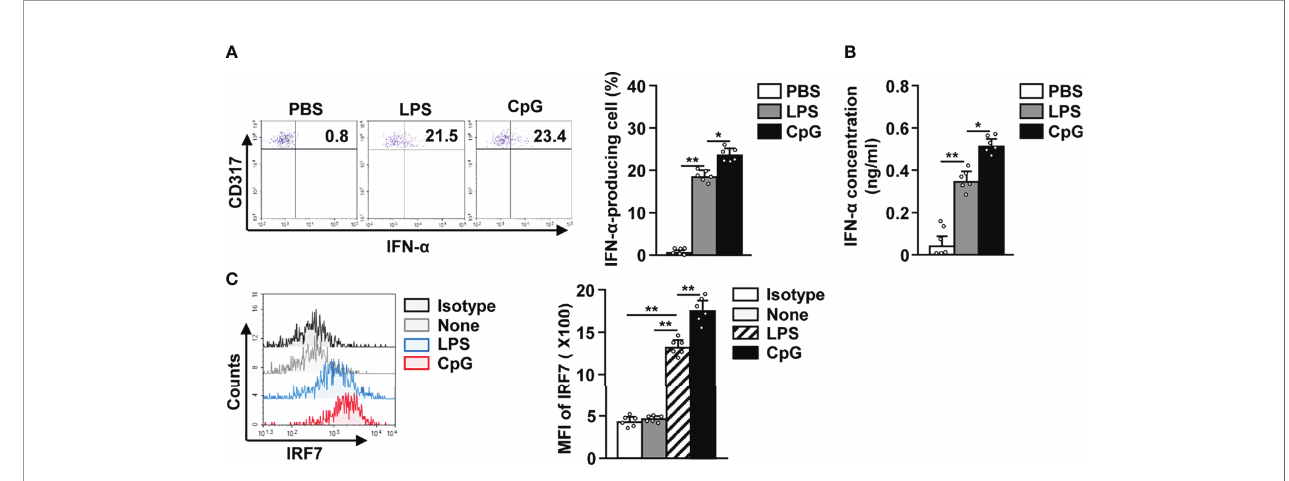
FIGURE 3 | LPS elicited interferon-alpha (IFN- a ) production in pDCs. The LPS (0.1 mg/kg) and CpG (10 mg/kg) were i.p. injected in C57BL/6 mice. Twelve hours after treatment, spleens were harvested and the splenocytes cultured in 2 m M monensin solution for 2 h. (A) Intracellular production of IFN- a in pDCs was shown (left panel). Mean percentage of IFN- a -producing cells was shown (right panel) (n = 6 mice, two-way ANOVA, mean±SEM, **p < 0.01, *p < 0.05 ). (B) Serum concentration of IFN- a was measured by ELISA (n = 6 mice, two-way ANOVA, mean±SEM, **p < 0.01, *p < 0.05 ). (C) Intracellular expression levels of interferon regulatory factor 7 (IRF7) were measured in pDCs (left panel). MFI of IRF7 expression levels was shown (right panel) (n = 6 mice, two-way ANOVA, mean±SEM, **p < 0.01